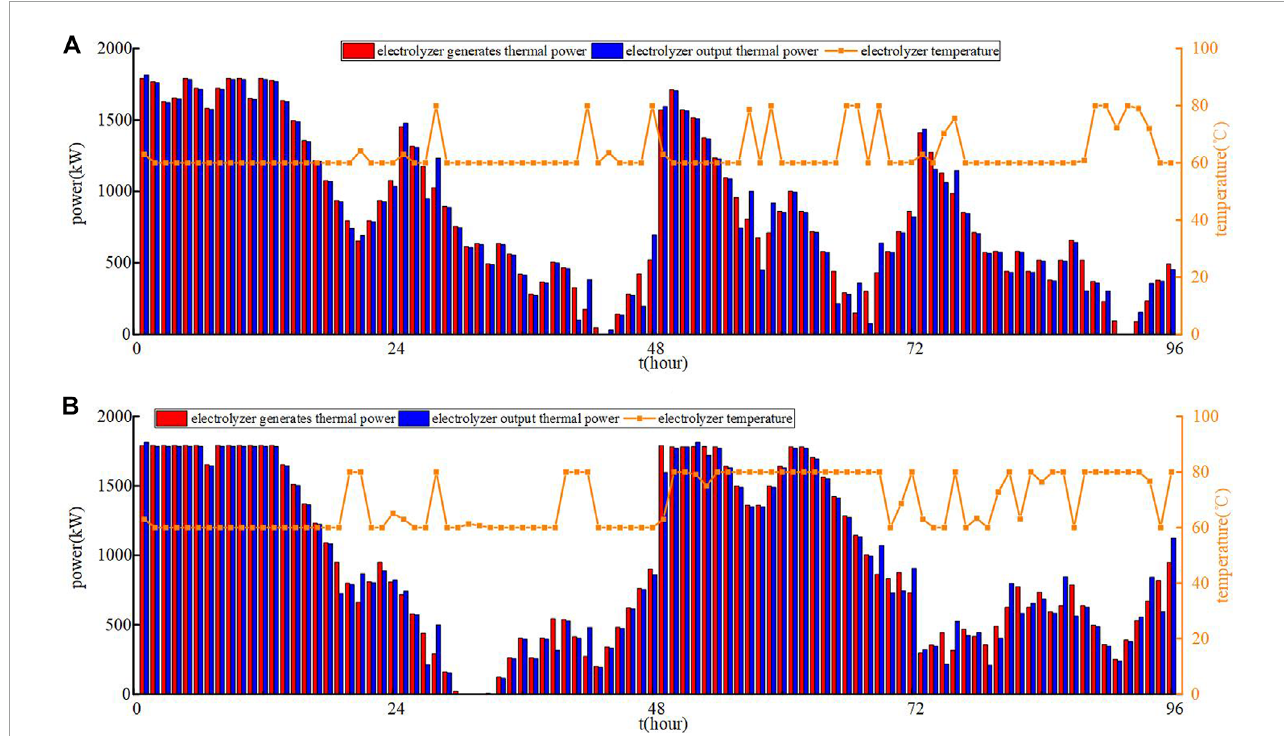
FIGURE 8 The relationship between thermal energy and temperature of electrolyzer. (A) Case 1. (B) Case 2.